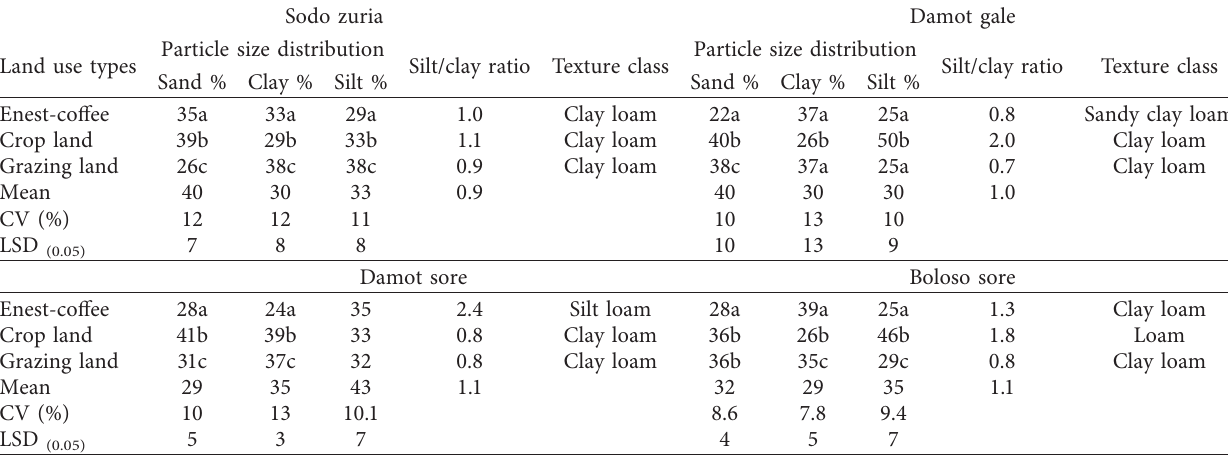
Table 1: Mean values ( n � 108) of particle size distribution and texture class of different locations and land use types of study areas.